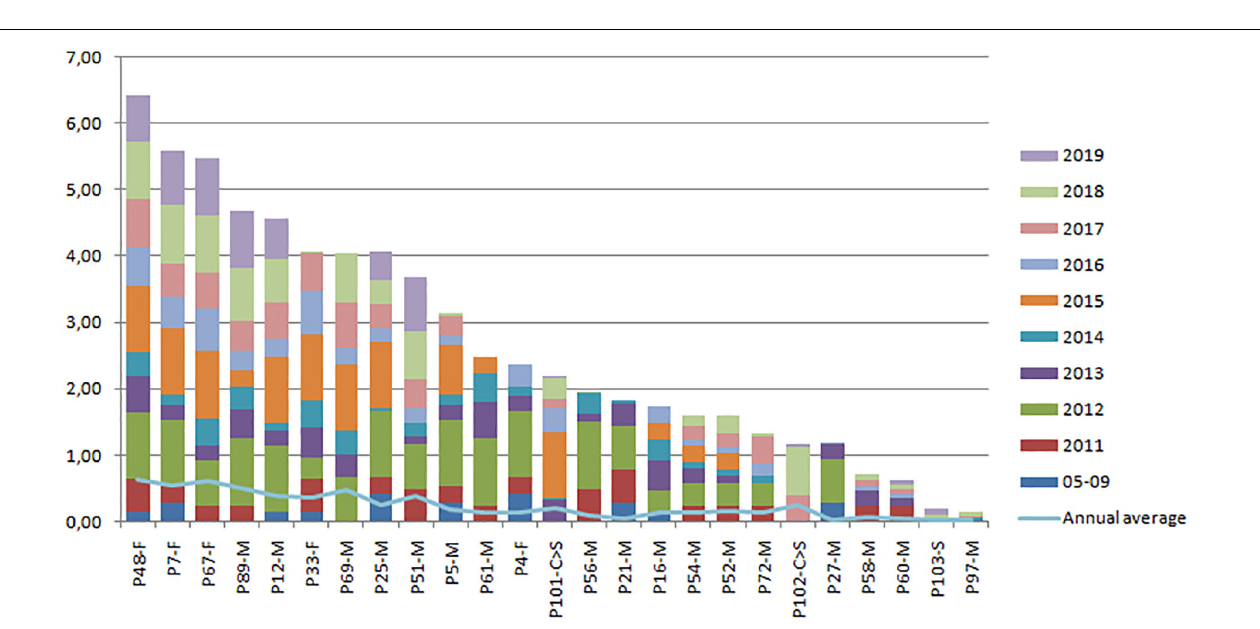
FIGURE 8 | Cumulative annual residency level of resident individuals in the Posorja community during the period 2011–2019. Each color represents 1 year. F = adult female, M = adult male, S = subadult, C = calf. The light blue line indicates the annual average of the residence level of each individual.